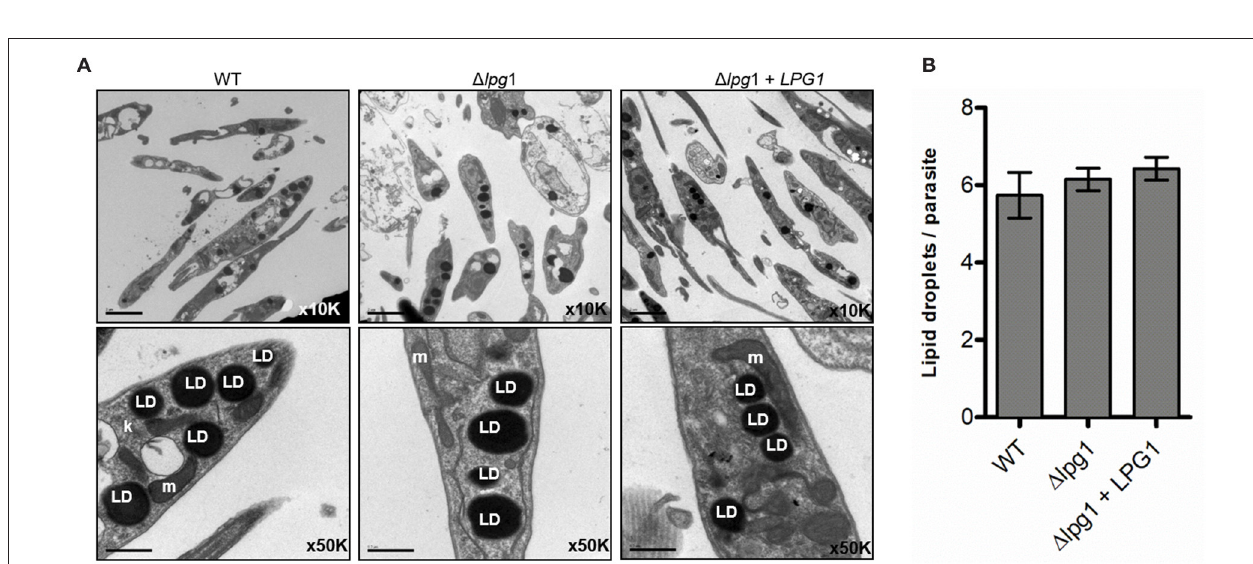
FIGURE 3 | Deletion of LPG1 does not alter LD formation in Leishmania infantum . (A) Panels show stationary phase WT, 1 lpg1 and 1 lpg1 + LPG1 promastigotes analyzed by transmission electron microscopy (TEM) and photographed under a JEOL 1230 microscope. (B) Bars represent the mean number of LD ± SE in WT, 1 lpg1 or 1 lpg1 + LPG1 parasites stained with osmium tetroxide. k, kinetoplast; LD, lipid droplets; m, mitochondrion. Scale bar, 0.5 µ m.